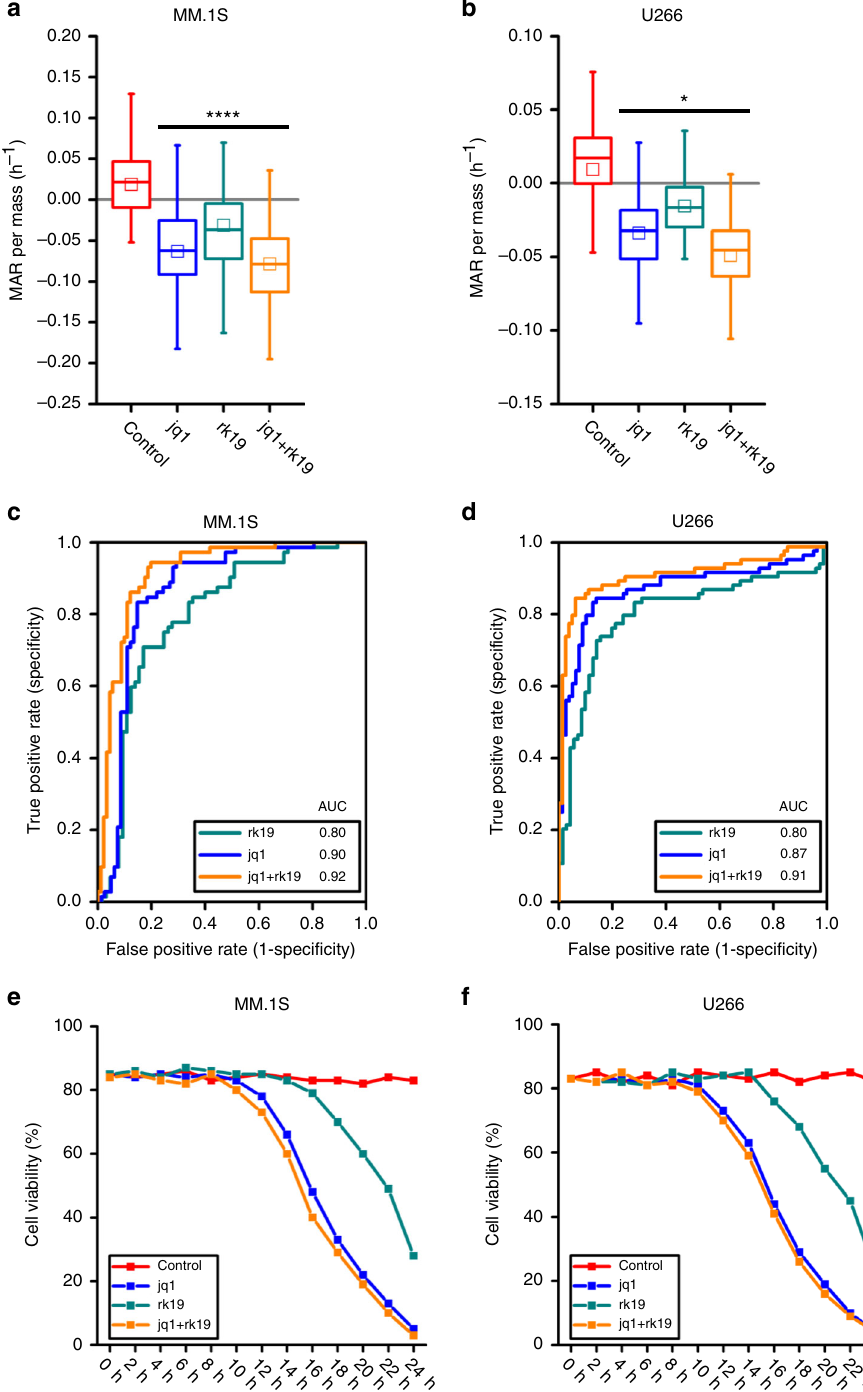
Fig. 5 MAR de fi nes sensitivity of human MM.1S and U266 cells to therapy jq1, rk19, and their combination. a , b MAR per mass distributions of MM.1S cells treated with 50 nM jq1, 20 µ M rk19 and U266 cells treated with 200 nM jq1, 20 µ M rk19 for 3 h. MAR per mass of both cell lines reduces upon exposure to both drug treatment. Boxes represent the inter-quartile range and white squares the average of all measurements. p values are calculated using Welch ’ s t - test, comparing treated cells to the control (only cell media), and were Bonferroni corrected. **** p < 0.0001 in highlighted segments. For MM.1S cells; p (control vs. jq1) = 6.4 × 10 − 10 , p (control vs. rk19) = 3.9 × 10 − 5 , p (control vs. jq1 + rk19) = 8.7 × 10 − 21 and * p < 0.05 in highlighted segments for U266 cells; p (control vs. jq1) = 1.3 × 10 − 6 , p (control vs. rk19) = 0.013, p (control vs. jq1 + rk19) = 7.0 × 10 − 11 . From left to right, number of cells in MAR measurement n (MM.1S) = 72, 82, 65, 91 and n (U266) = 84, 79, 71, 81. c , d ROC curves of control and treatment (jq1, rk19, jq1 + rk19) data for MM.1S and U266 cells. e , f Cell viability analysis for MM.1S and U266 cells under different drug